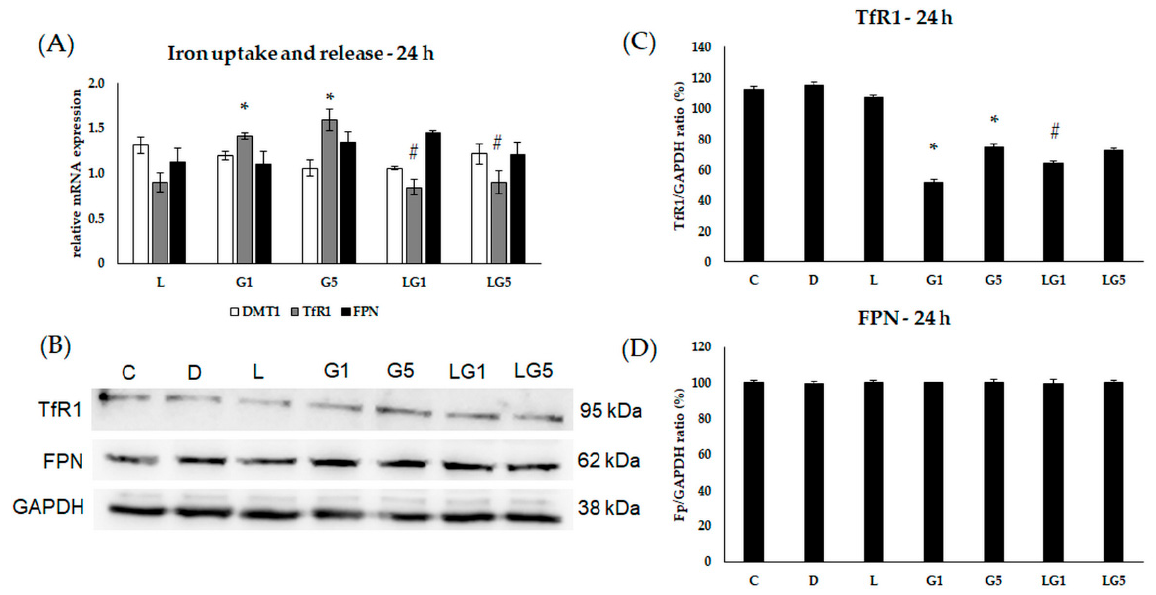
Figure 6. Determination of mRNA expression ( A ) and protein ( B – D ) levels of TfR1, DMT1, and FPN after lutein and Glu treatments of the SH-SY5Y cells at 24 h SH-SY5Y cells were treated with 10 ng/ µ L of lutein, 1 mM, 5 mM Glu, lutein with Glu together to detect the changes in the expression of TfR1, DMT1, and FPN. The gene expression measurements were performed by SYBR Green RT-PCR protocol using β -actin as a housekeeping gene. The relative expression of controls was regarded as 1. The protein expression measurements were performed by semi-dry Western blotting using GAPDH as a loading control. The protein’s OD was expressed as a percentage of the target protein/GAPDH ratio. The bars represent the mean values ( ± standard deviation error bars, SD) of three independent experiments ( n = 3) performed in triplicate and are presented relative to their control cells. The * shows the statistical significance of Glu treatments compared to control, # signs the statistical significance of combined (lutein with Glu) treatments compared to the Glu treatments at 24 h ( p < 0.05).